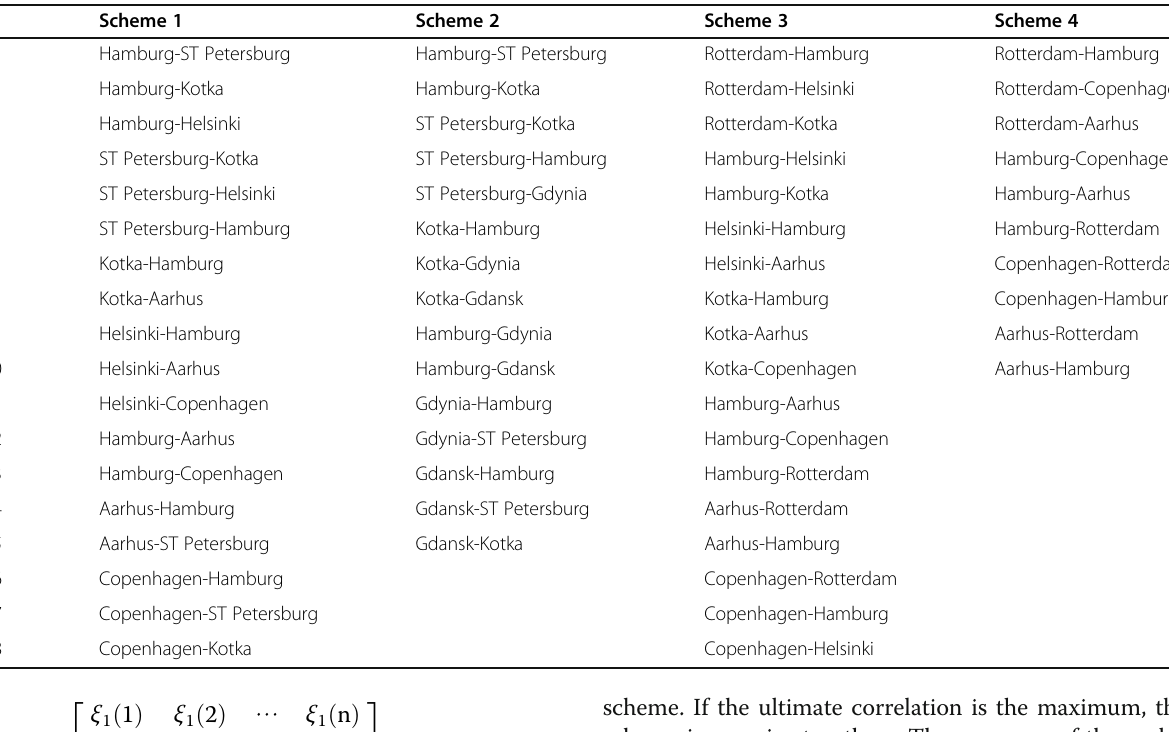
Table 9 Available Intra-Europe Routing under Four Alternatives of Feeder Network Design (Source: authors) Scheme 1 Scheme 2